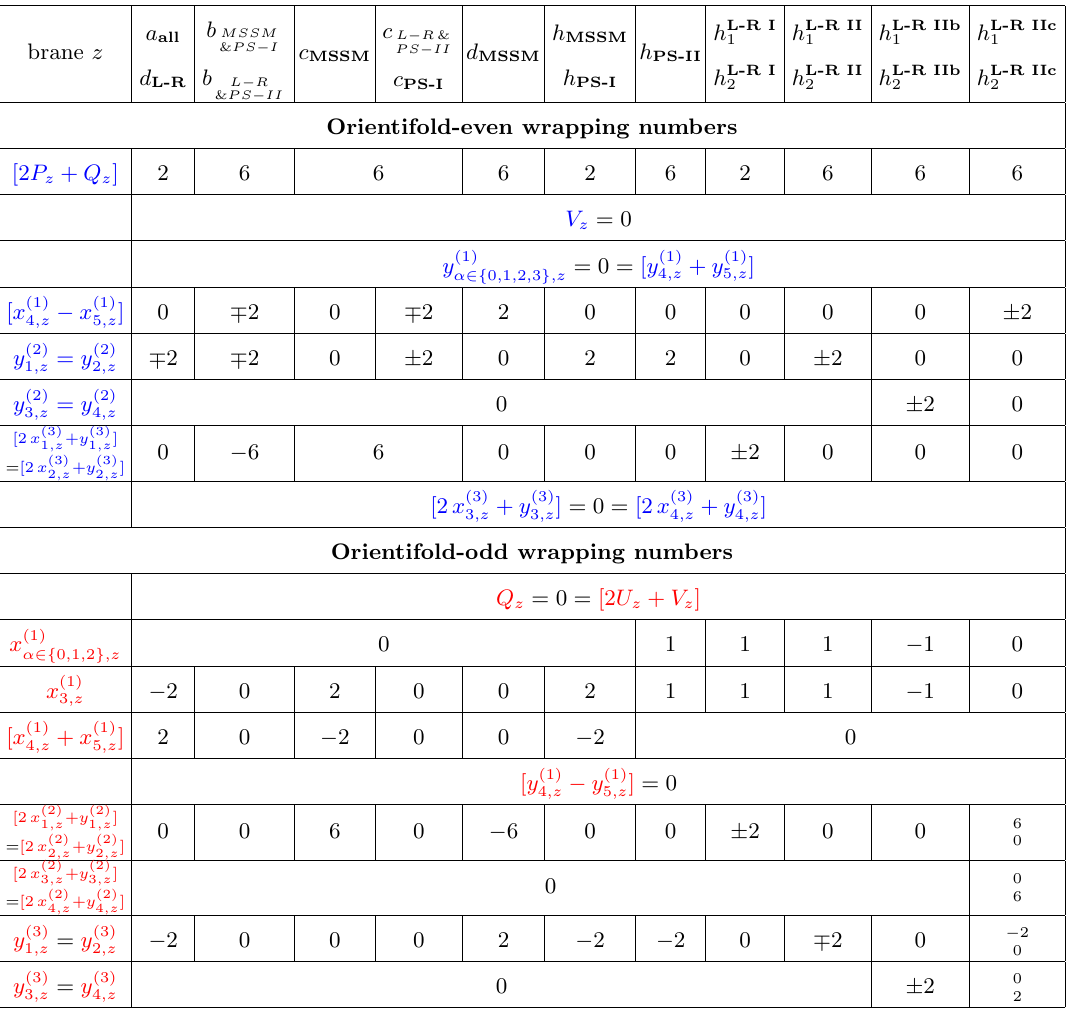
Table 11 . Orientifold-even and -odd wrapping numbers of the phenomenologically appealing global MSSM, L-R symmetric and PS models on T 6 = ( Z 2 (cid:2) Z 6 (cid:2) (cid:10) R ) with discrete torsion discussed in sections 3.3, 3.4 and 3.5, respectively. A non-vanishing orientifold-odd wrapping number stabilises the associated deformation modulus according to table 8. If some orientifold-odd wrapping number vanishes, but the orientifold-even number with identical (cid:12)xed point labels is non-zero, the associated tree-level gauge coupling in equation (3.3) experiences a (cid:13)at direction in the deformation modulus, see table 12 for details.